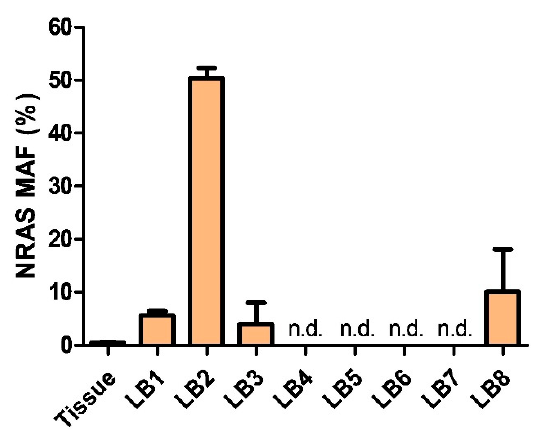
Figure 3. Liquid biopsy shows the mutant allele frequency (MAF) of mutant NRAS in tumor tissue (mean of 2 experiments) and in CSF liquid biopsy (mean of 5 experiments each). LB4-LB7 were negative for NRAS(Q61R) and NRAS-wt. LB 8 showed an increase of NRAS(Q61R) . Additional information given in Supplementary Materials Figure S2.